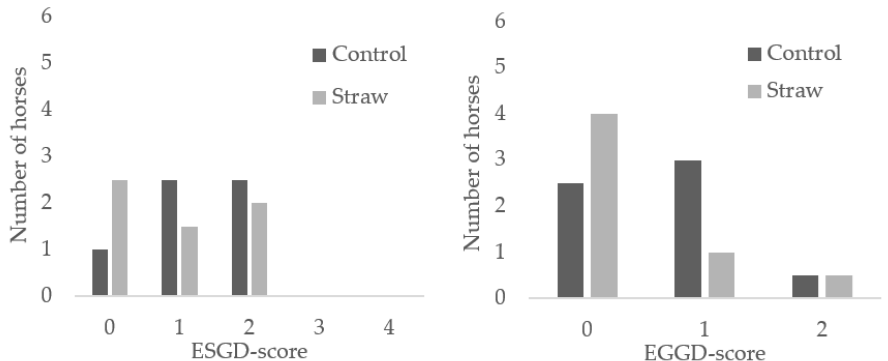
Figure 2. Number of observations (horses) in each score for equine squamous gastric disease (ESGD) and glandular equine glandular gastric disease (EGGD) in six horses fed a control diet (grass haylage only) and a diet with 50% wheat straw and 50% grass haylage (of DM) for three weeks each in a 2 × 21-day cross-over design.